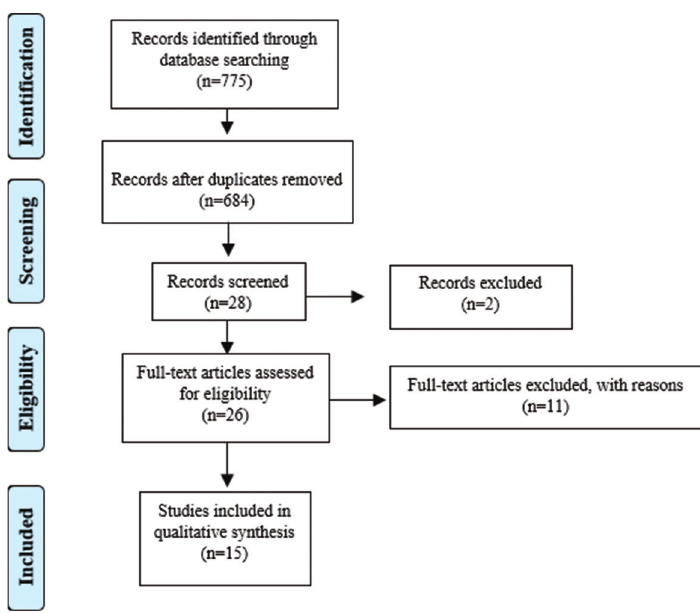
Figure 1 - Flowchart of bibliographic research and selection of studies for this systematic review according to